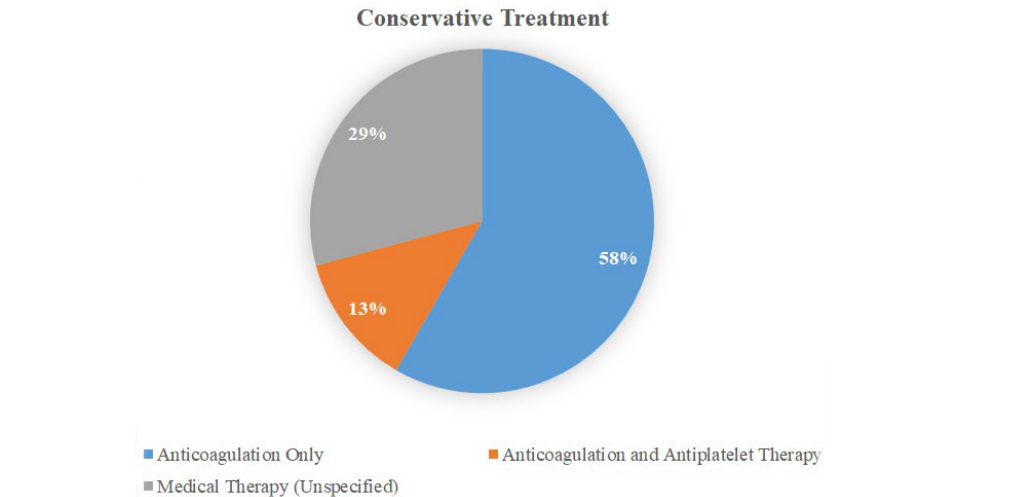
Figure 5. The non-invasive treatment modalities used for aortic thrombus with COVID-19 infection